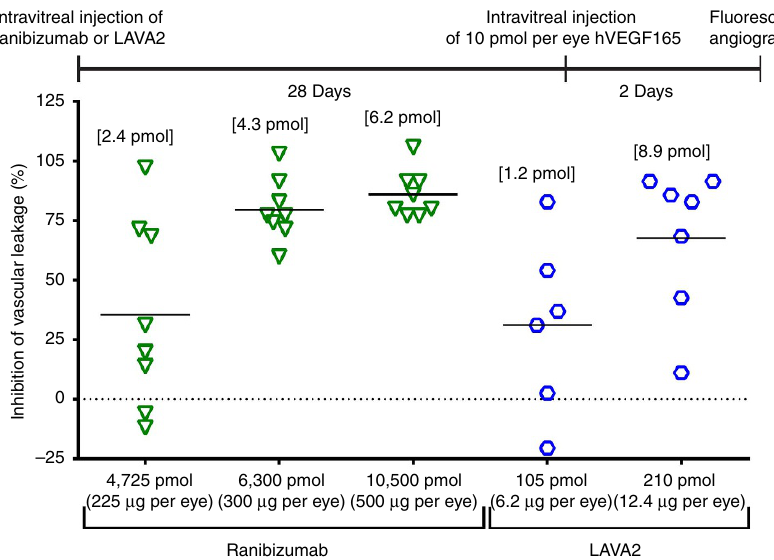
Figure 7 | Efficacy of ranibizumab and LAVA2 in the rabbit retinal vascular leakage model. LAVA2 at a dose of 210pmol demonstrated similar efficacy to ranibizumab doses of 6,300 or 10,500pmol when administered intravitreally 30 days before fluorescein angiography. The terminal vitreal levels (values in brackets above the datapoints) of LAVA2 (8.9pmol) are higher than the terminal vitreal levels of ranibizumab at all doses (2.4 to 6.2pmol) even